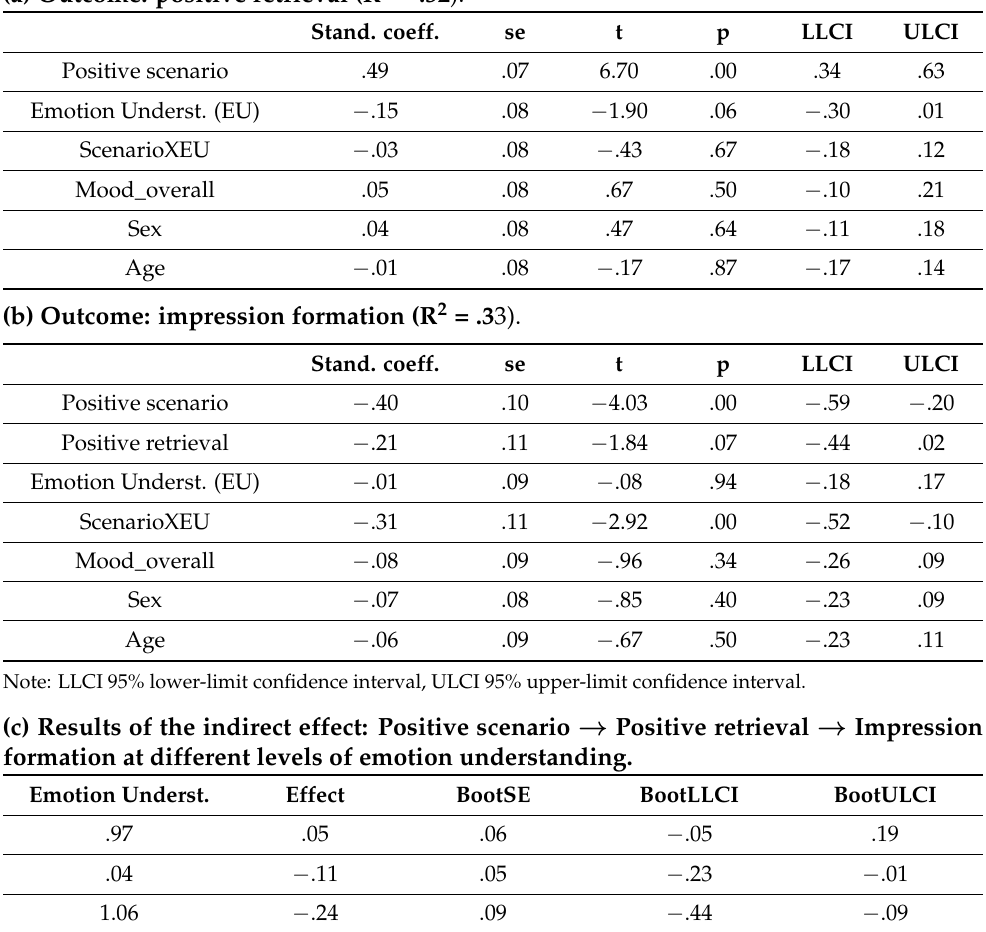
(c) Results of the indirect effect: Positive scenario → Positive retrieval → Impression formation at different levels of emotion understanding. Emotion Underst. Effect BootSE BootLLCI BootULCI .97 .05 .06 .19